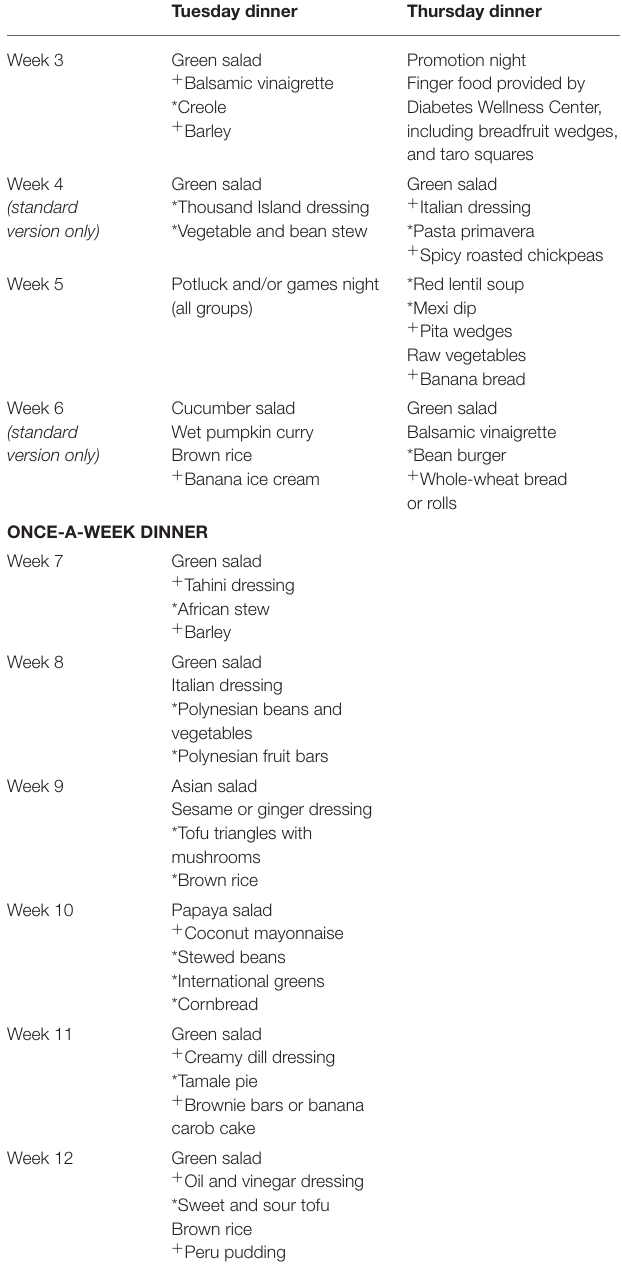
TABLE 3 | Study menus for weeks